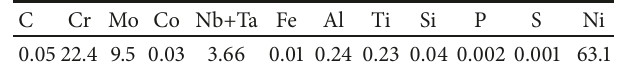
Figure 1: Microstructure of solution alloy by means of